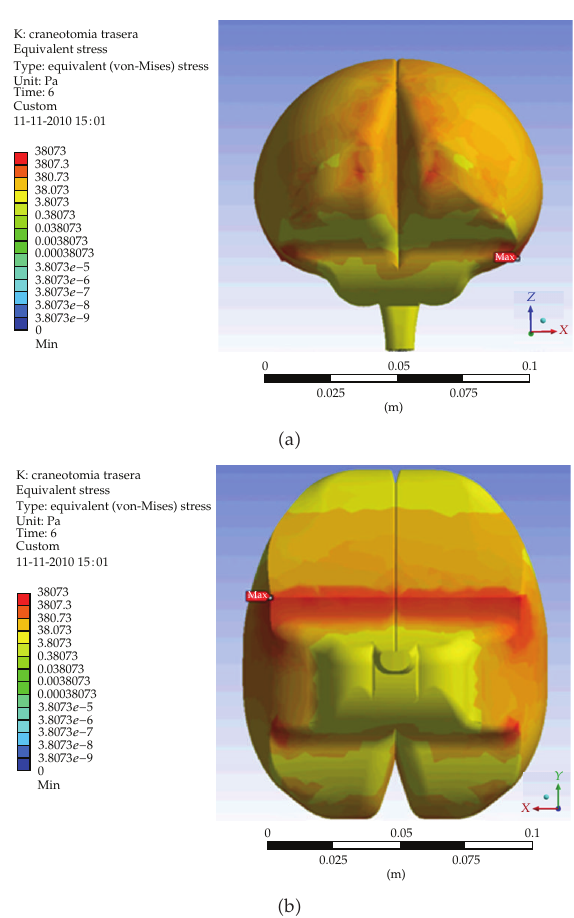
Figure 9: E ff ective stress for posterior craniotomy, hyperelastic second-order Ogden model.